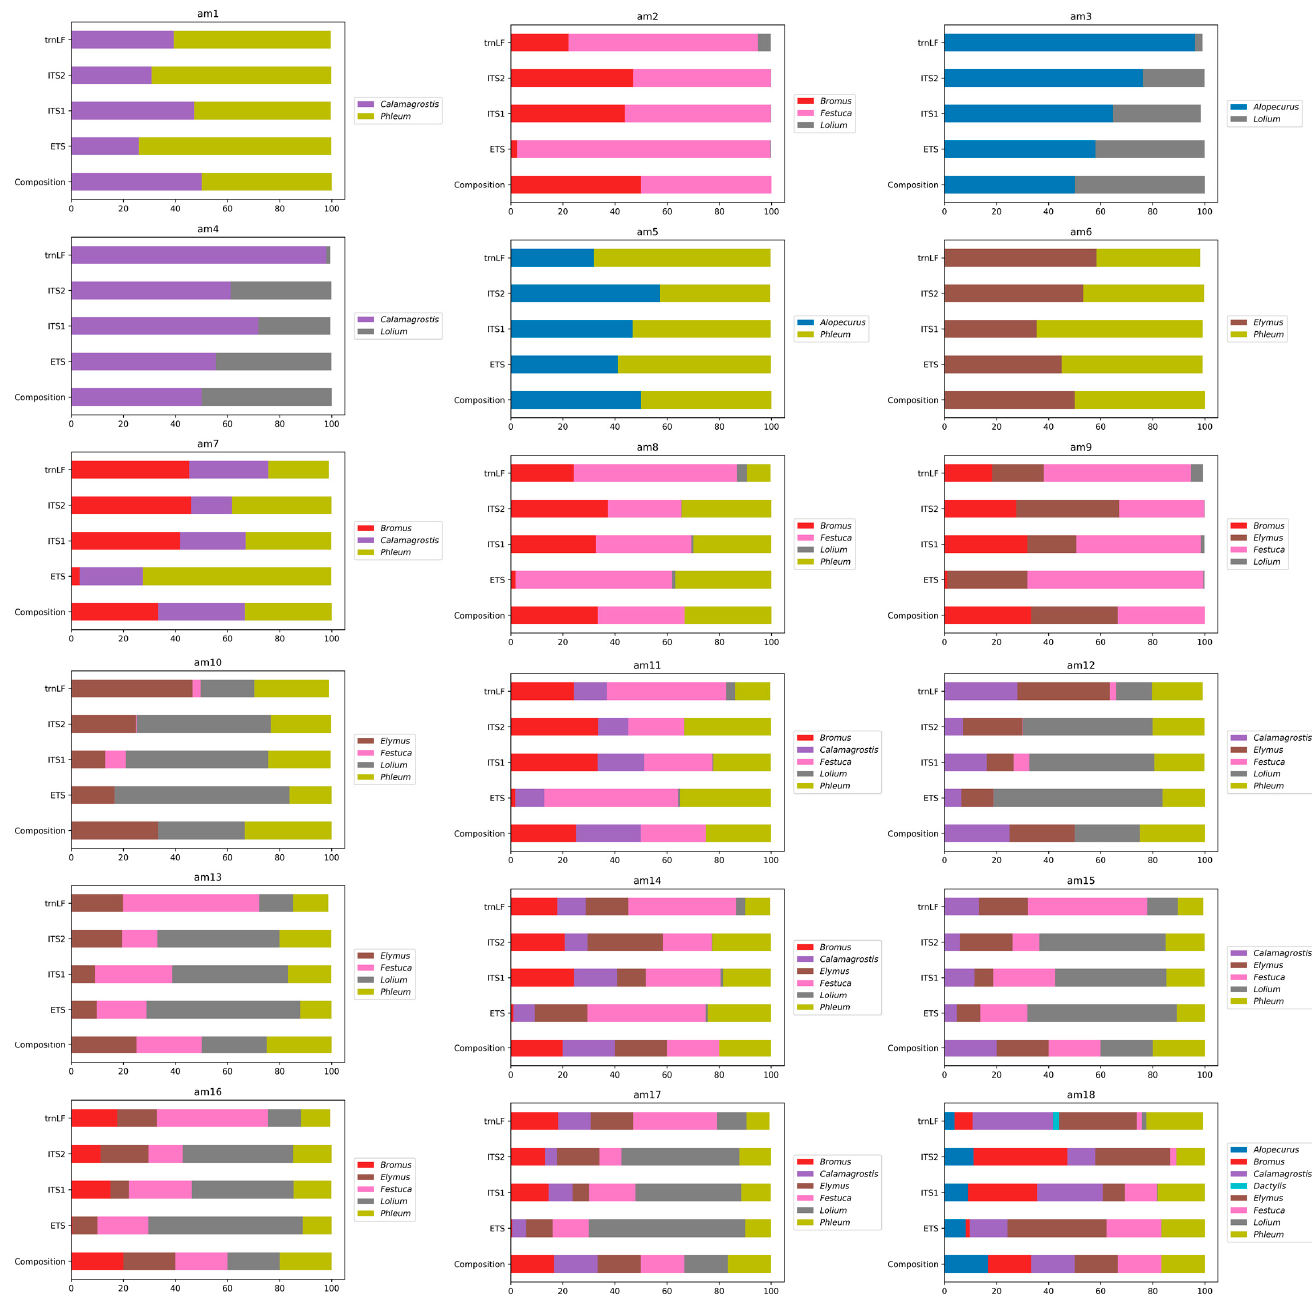
Figure 3. Metabarcoding results for the artificial pollen